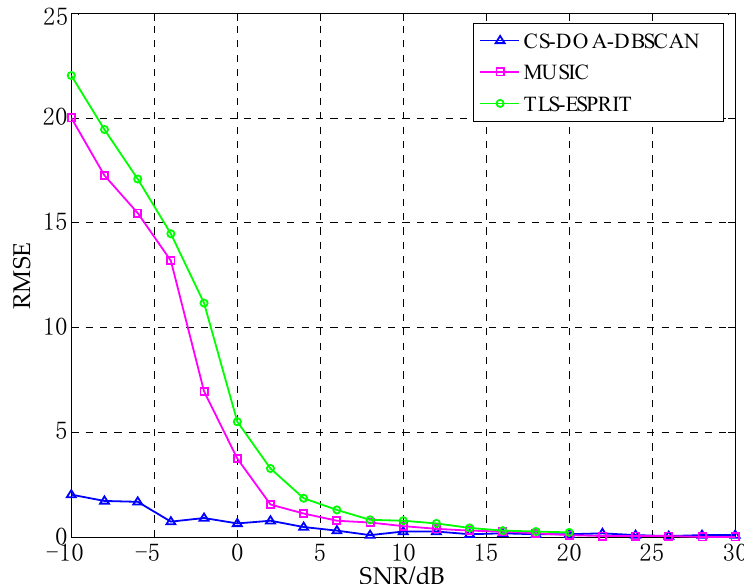
Figure 15. The RMSE of the DOA estimation of each algorithm under different SNRs.